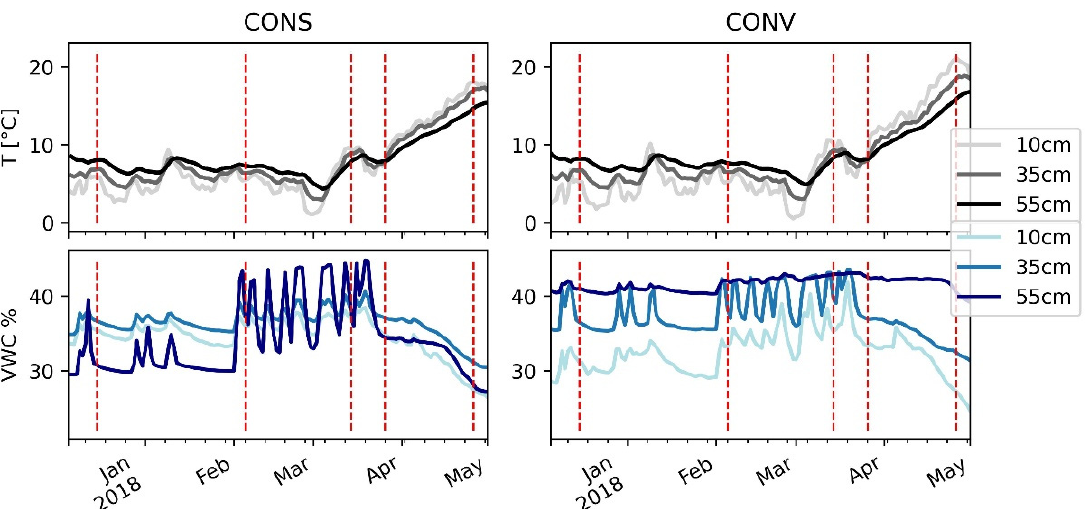
Figure 4. Time series of soil temperature [°C] and soil volumetric water content [%] from the sensors installed in the two field sites (CONV and CONS). Dashed red lines show the time of ERT and EMI surveys. Data shown are the average of the three stations for each treatment. Soil BD was significantly affected by the different treatments in all three layers, be- ing 1.28 ( ± 0.08) g cm − 3 vs. 1.08 ( ± 0.13) g cm − 3 in 0–25 cm, 1.48 ( ± 0.08) g cm − 3 vs. 1.39 ( ± 0.09) g cm − 3 in 25–50 cm, and 1.51 ( ± 0.02) g cm − 3 vs. 1.34 ( ± 0.14) g cm − 3